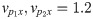
Power spectrum of parkinsonian STN activity as a function of DBS pulse frequency.A simulation of 40 s is used with νζx = −1.2 mVs and vp1x,vp2x=1.2 mVs and a power spectrum of the STN firing rate is calculated over the time window t = 20–40 s.